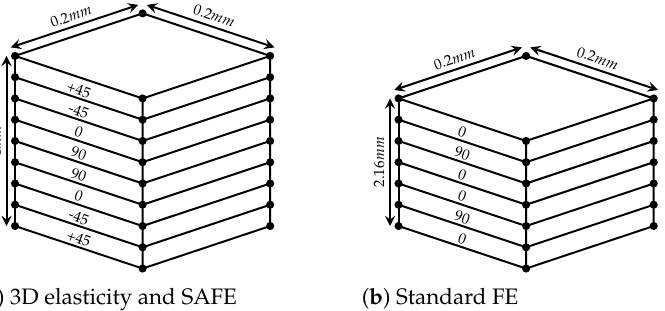
Figure 2. Single periodic section modelled in FE using standard 8-node hexahedral